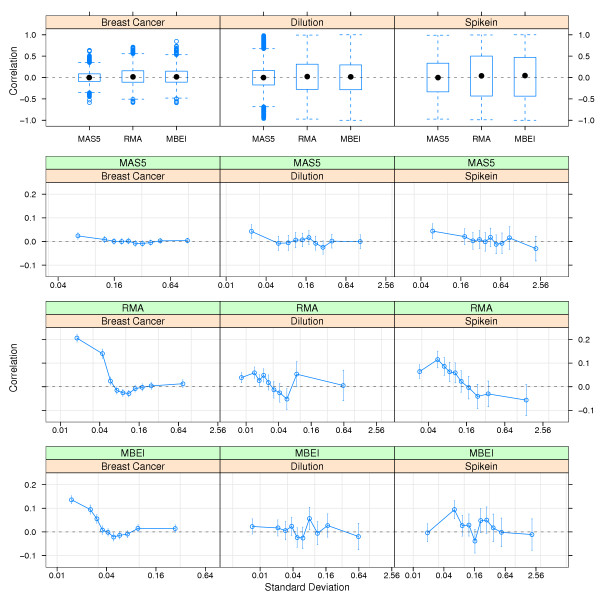
Correlations between the normalized expression values of the 5000 randomly selected pairs of genes. The most commonly used normalization procedure was chosen for each expression measure: global mean normalization for MAS5, quantile normalization for RMA, and invariant set normlization for MBEI, see Methods. Top: The distributions of the correlation coefficients are now centered at zero for all expression measures and data sets. Bottom: Summary curves plotting mean correlations versus median product of standard deviations for pairs of genes in non-overlapping intervals along the horizontal axis; 95% confidence intervals are shown as vertical bars. Normalization has removed most of the technical correlation (as seen in the reduced vertical scale compared to Figure 1), but there are still systematic relationships between correlations and standard deviations for RMA and MBEI, which are most pronounced for the Breast Cancer data set.